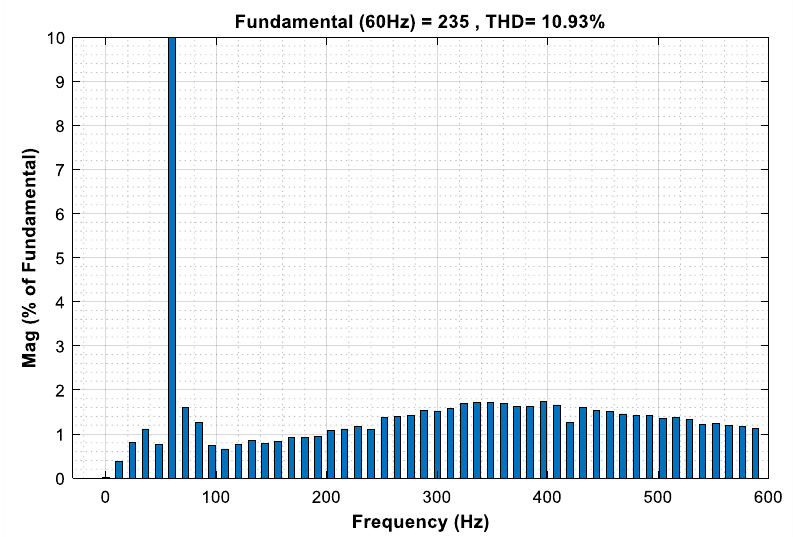
Figure 15. Total harmonic distortion (THD) analysis of the grid current in the original case.